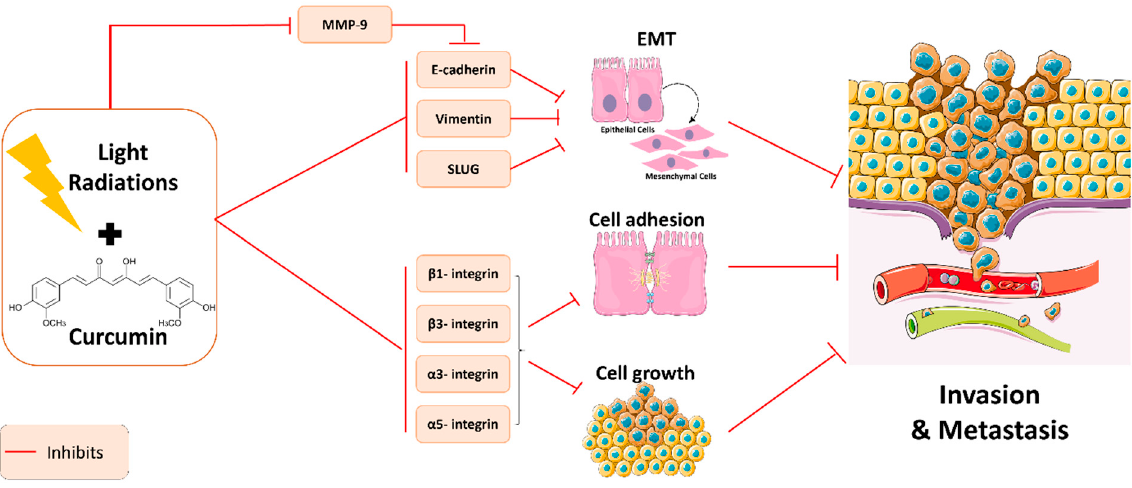
Figure 2. Molecular pathways underlying the anti-metastatic and anti-invasive properties of curcumin in combination with light radiation therapy.